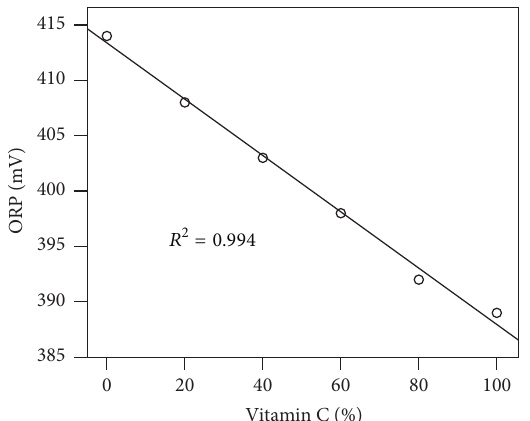
Figure 4: Liner relationship between the ORP value and the concentration of vitamin C.